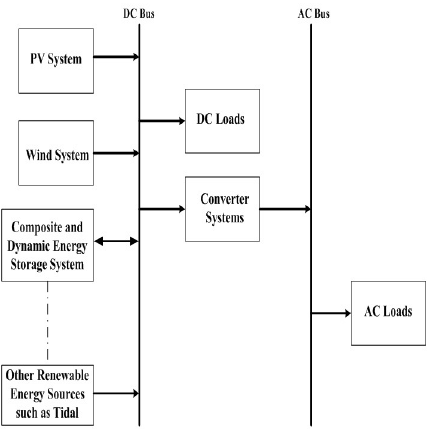
Figure 14. Basic block diagram of an hybrid DER